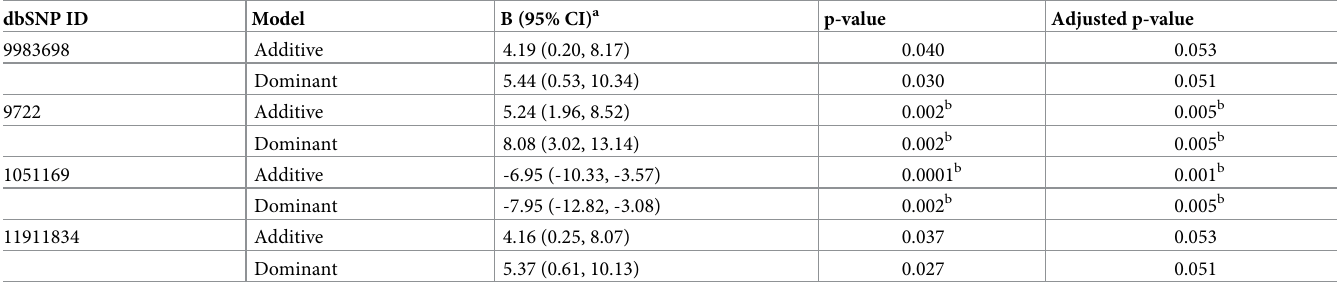
Upon further analysis of data by performing regression analyses separately in males and females, rs1051169 was found to exhibit strong sex-specific association with CPI only in females (Table 6). The G allele of rs1051169 was found to be associated with decrease CPI in females (additive model adjusted p = 0.001, dominant model adjusted p = 0.006) but not in males. A similar sex-specific association was observed for rs9722 (Table 6), where the A allele was associated significantly with increased CPI in females (adjusted p = 0.042) but not in males in the additive model. No sex-specific association with CPI was observed for the other Table 4. Single SNP regression analysis of